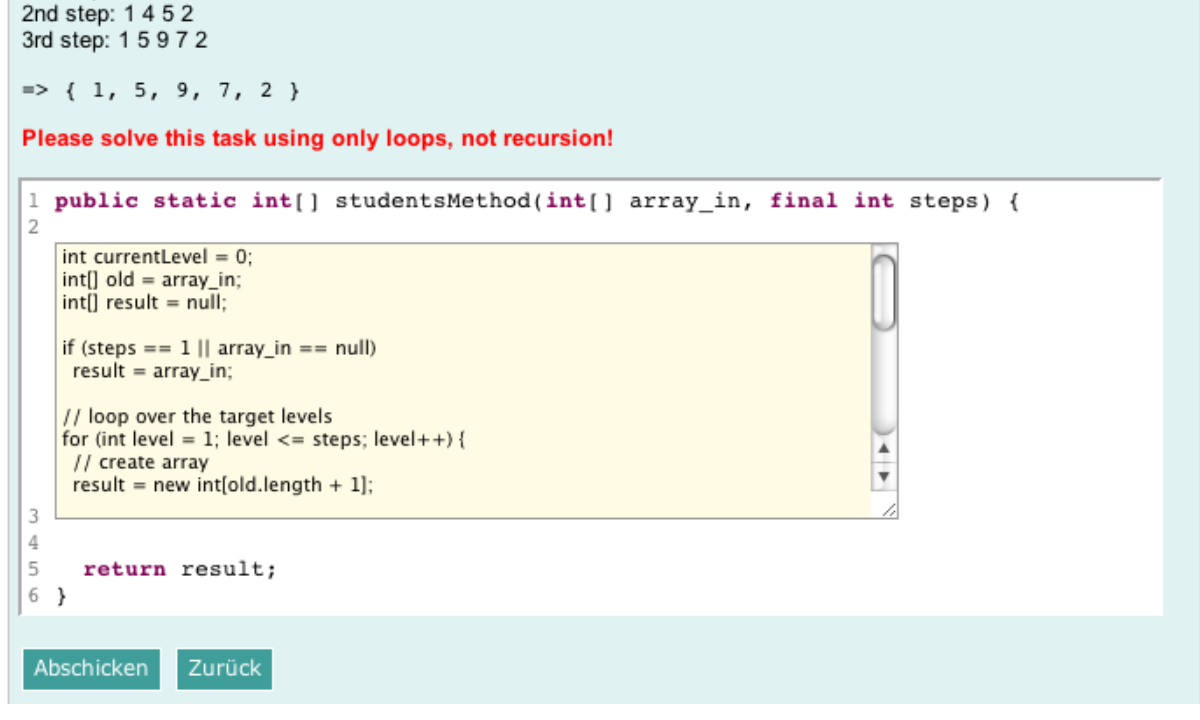
Figure 3. Example student code for a given WebTasks